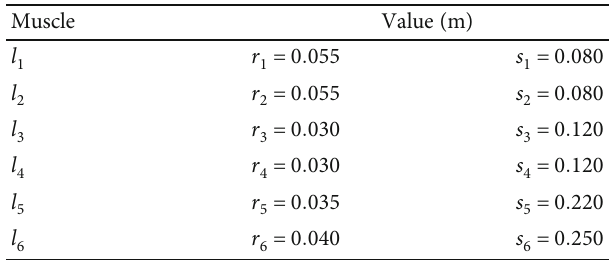
Table 1: Numerical values related to the muscle ’ s geometrical shape.